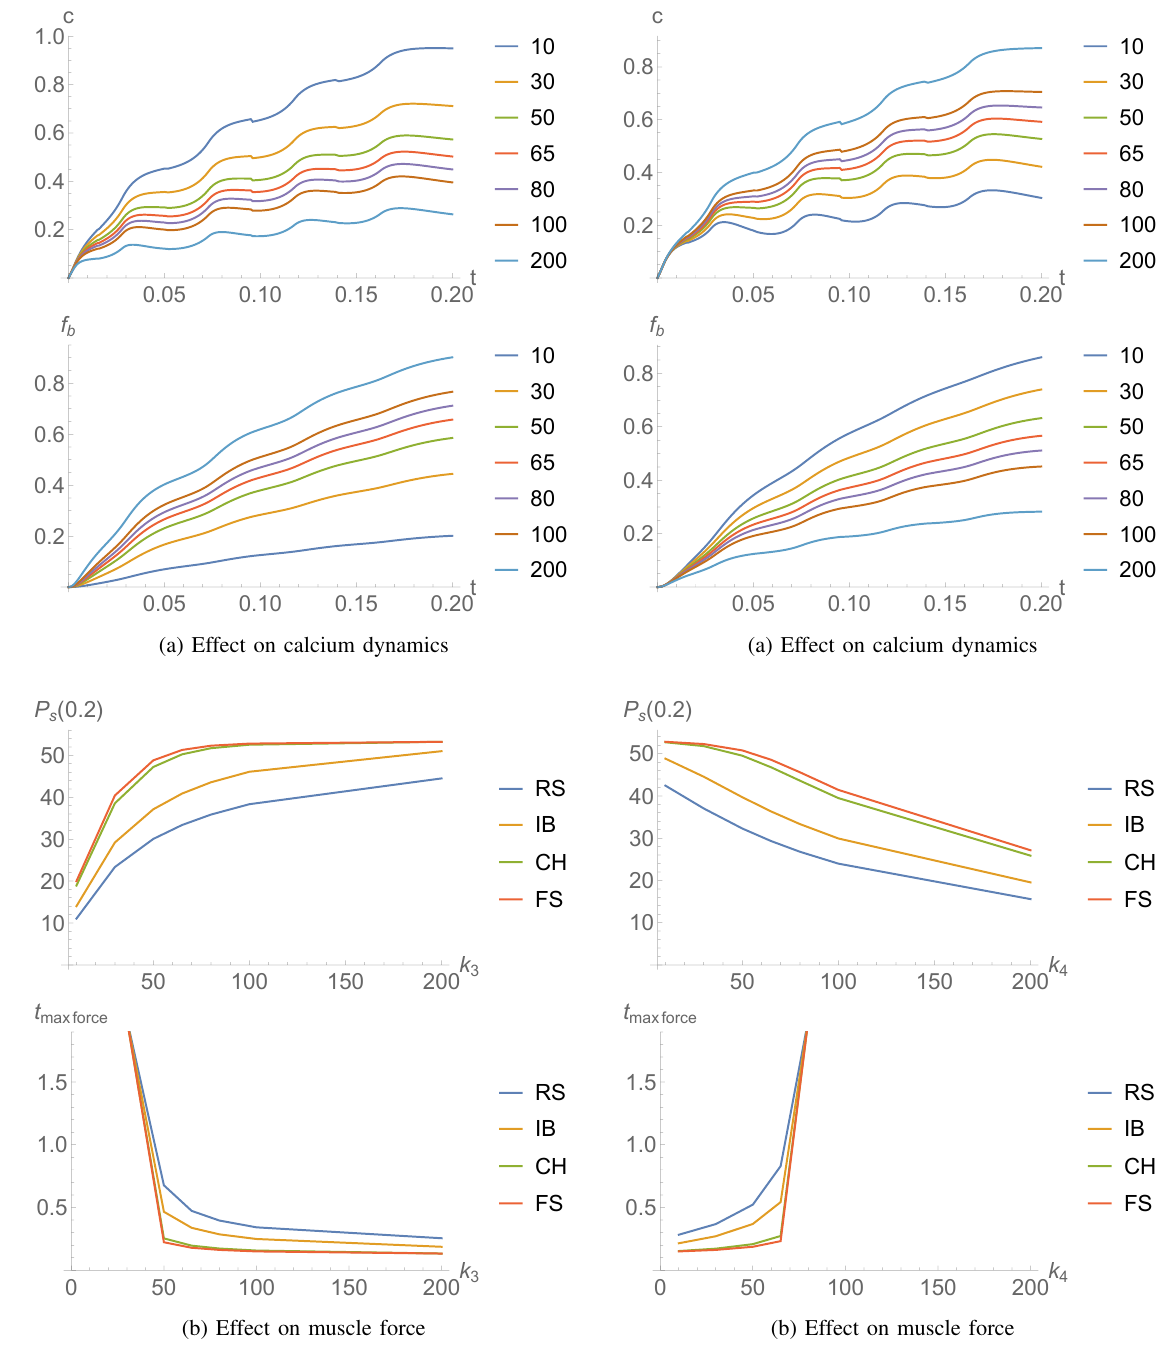
Fig. 7: Effect of varying the parameter k 3 . Fig. 8: Effect of varying the parameter k 4